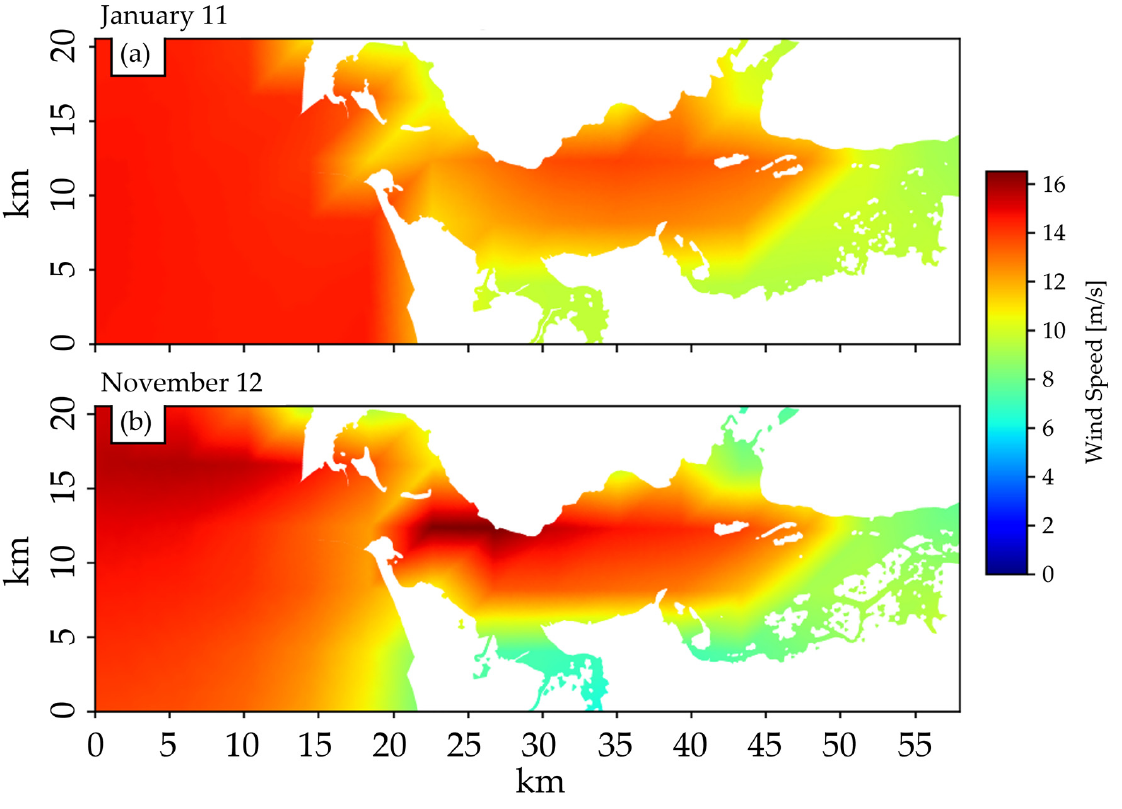
Figure A3. Maps of the modeled wind speed spatial variability over the Columbia River estuary. ( a ) Events of January and ( b ) November 2014 from the reference simulation with WRF4. During the two events, the wind is energetic in the central part of the lower estuary, with a peak in the north channel for the case of November.